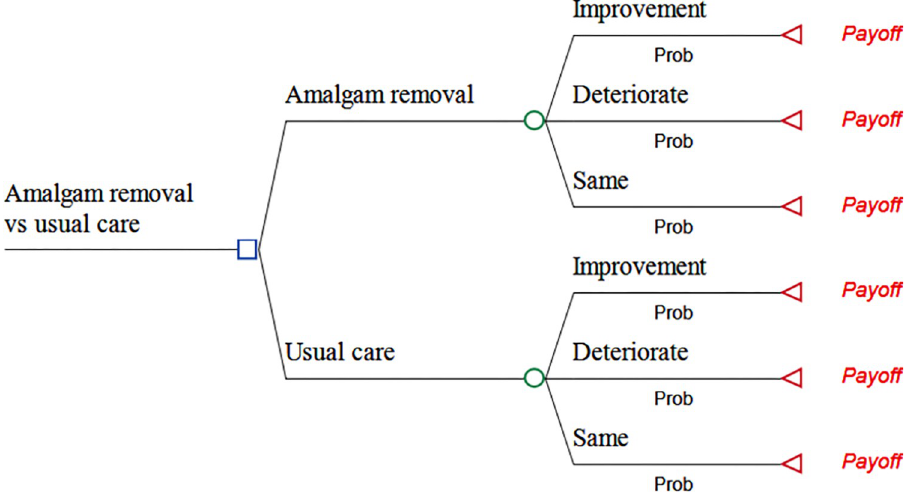
Fig 1. Decision model tree structure showing comparison of amalgam fillings removal (AR), and usual care (UC). The squares denote decision nodes, circles denote probability nodes, and triangles denote the terminal nodes.